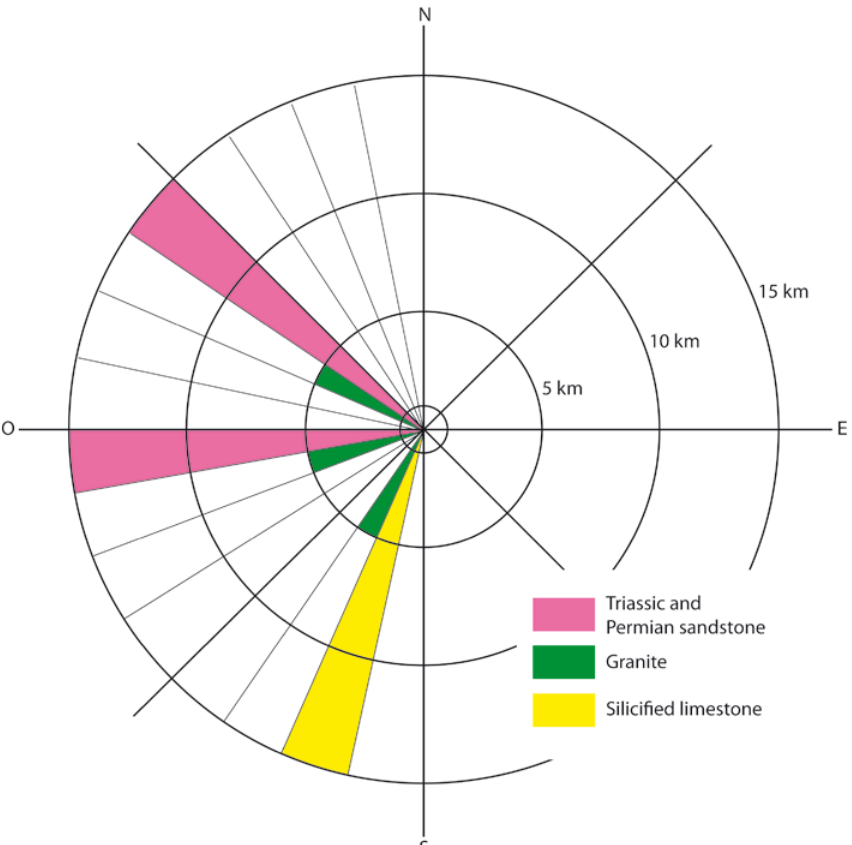
Figure 3. Sketch of the different potential rock outcrops directions in the surroundings of Dambach-la-Ville (CAD Jodry,